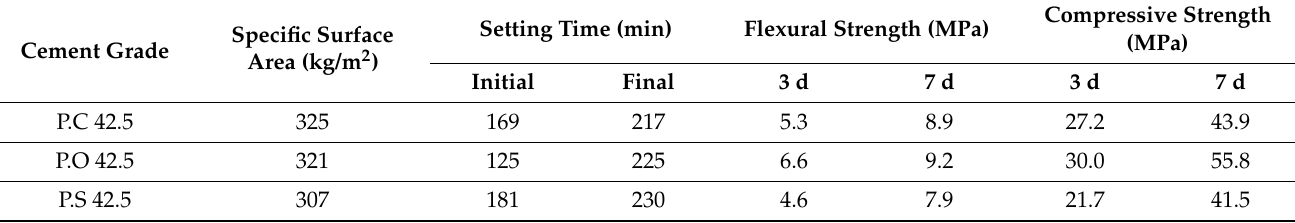
Table 1. Basic properties of